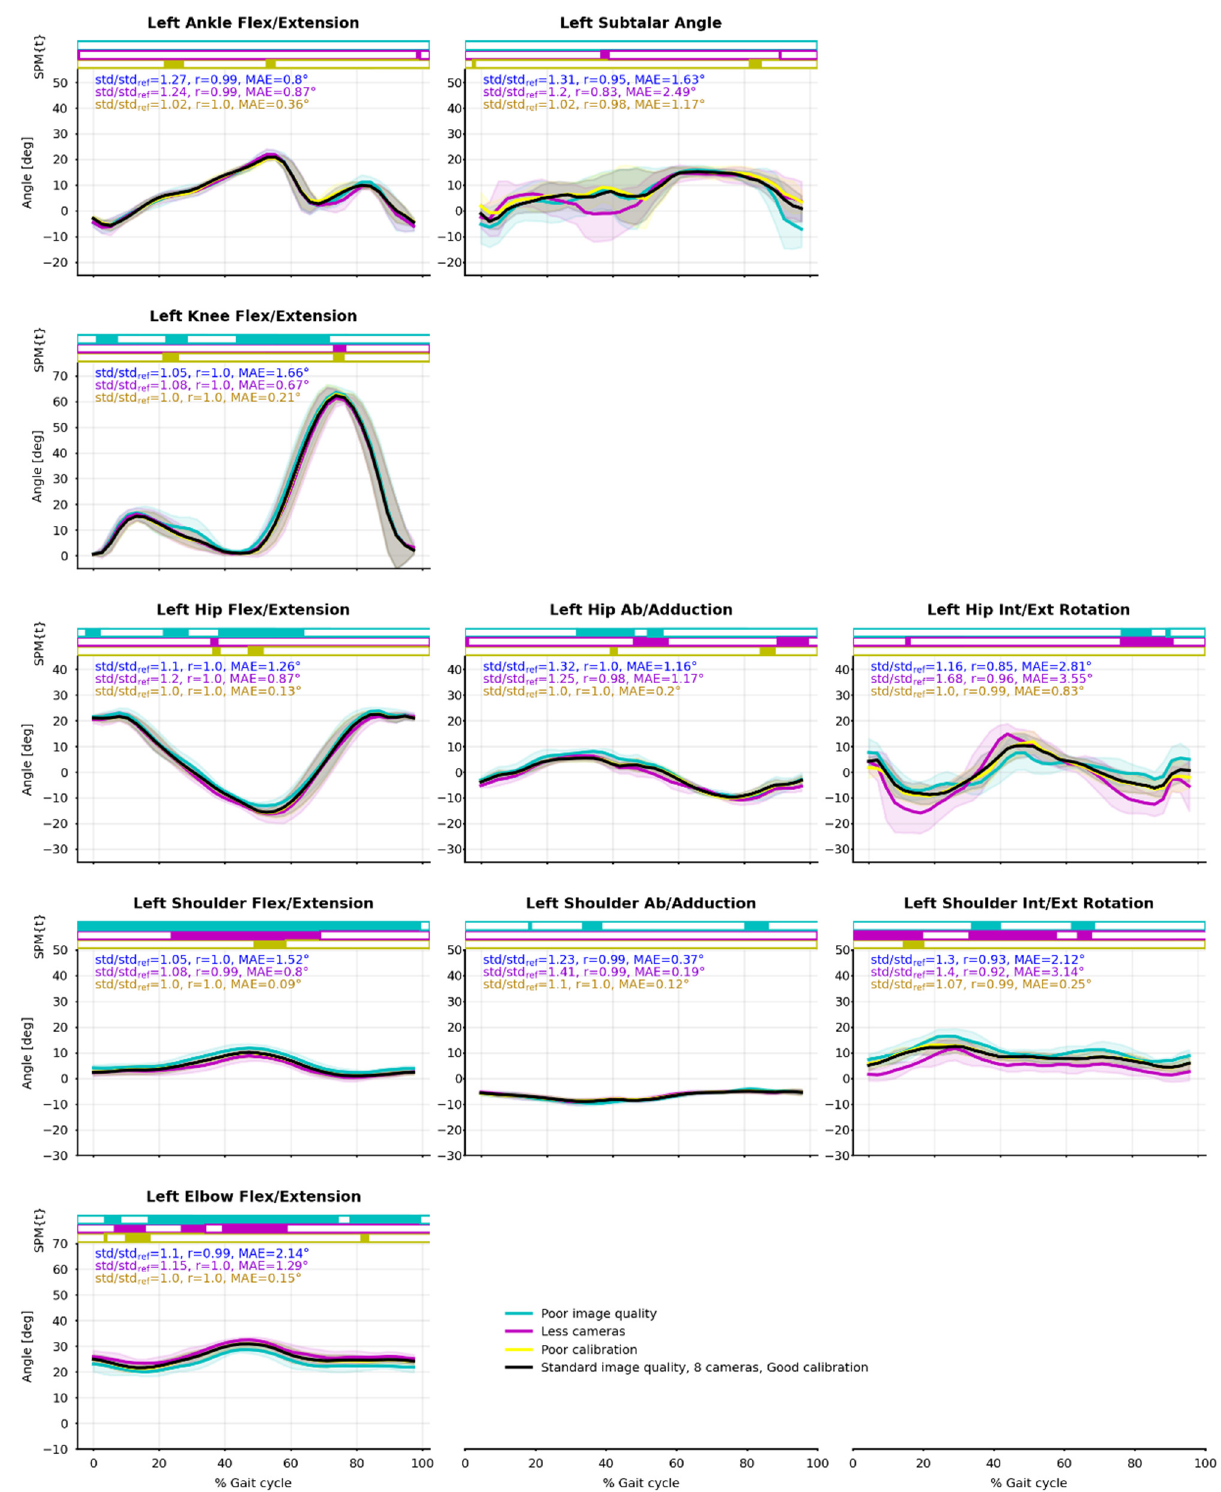
Figure 9. Joint angle means (solid line) and standard deviations (shaded area) from the eight captured cycles of walking. Reference condition (Ref) is black; degraded image quality (Im) is blue; four cameras instead of eight (4c) is purple; degraded calibration (Cal) is yellow. Pearson’s correlation coefficient (r) and mean absolute error (MAE) between Ref and Im, 4c, Cal are reported. Paired t-tests along time were computed by SPM-1D and are represented as bar plots above the curves: a color rectangle means that there was a cluster of statistically significant differences ( α = 0.05) at that moment. Running and cycling figures can be found in the Supplementary Material.